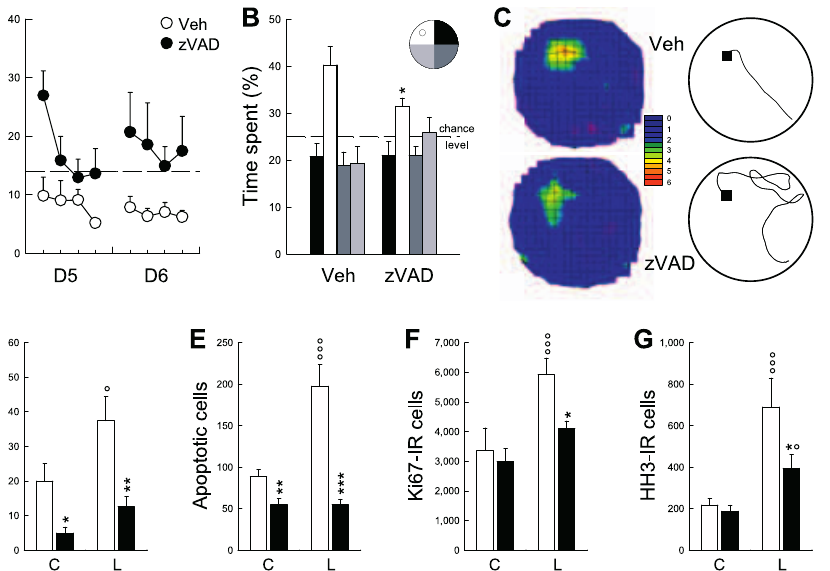
Figure 6. zVAD Infusion Blocks Learning-Induced Cell Death and Impedes Spatial Memory (A) Latency to reach the hidden platform in animals infused with zVAD ( (cid:4) ) or vehicle ( * ). The dashed line represents the mean escape latency across the first four training days. (B) Memory of platform location during a probe test (seventh day of testing) measured by the time spent in the target quadrant (open bar). A single asterisk (*) indicates p (cid:2) 0.05. (C) Spatial histograms of the animals’ locations and examples of swim paths to reach the platform location during the probe test (see Protocol S1 for more information). (D and E) Effects of zVAD (filled bars) and vehicle (open bars) treatments on cell death measured by the number of fractin-IR cells (D) and both pyknotic and karyorrhexic dying cells (E). (F and G) Effects of zVAD (filled bars) and vehicle (open bars) treatments on cell proliferation measured by the number of Ki67-IR cells (F) and HH3-IR cells (G). A single asterisk (*) indicates p (cid:2) 0.05, double asterisks (**) indicate p (cid:2) 0.01, and triple asterisks (***) indicate p (cid:2) 0.001, zVAD group compared to Veh group; a single circle ( 8 ) indicates p (cid:2) 0.05, and triple circles ( 888 ) indicate p (cid:2) 0.001, Learning group (L) compared to Control group (C). Error bars represent the s.e.m